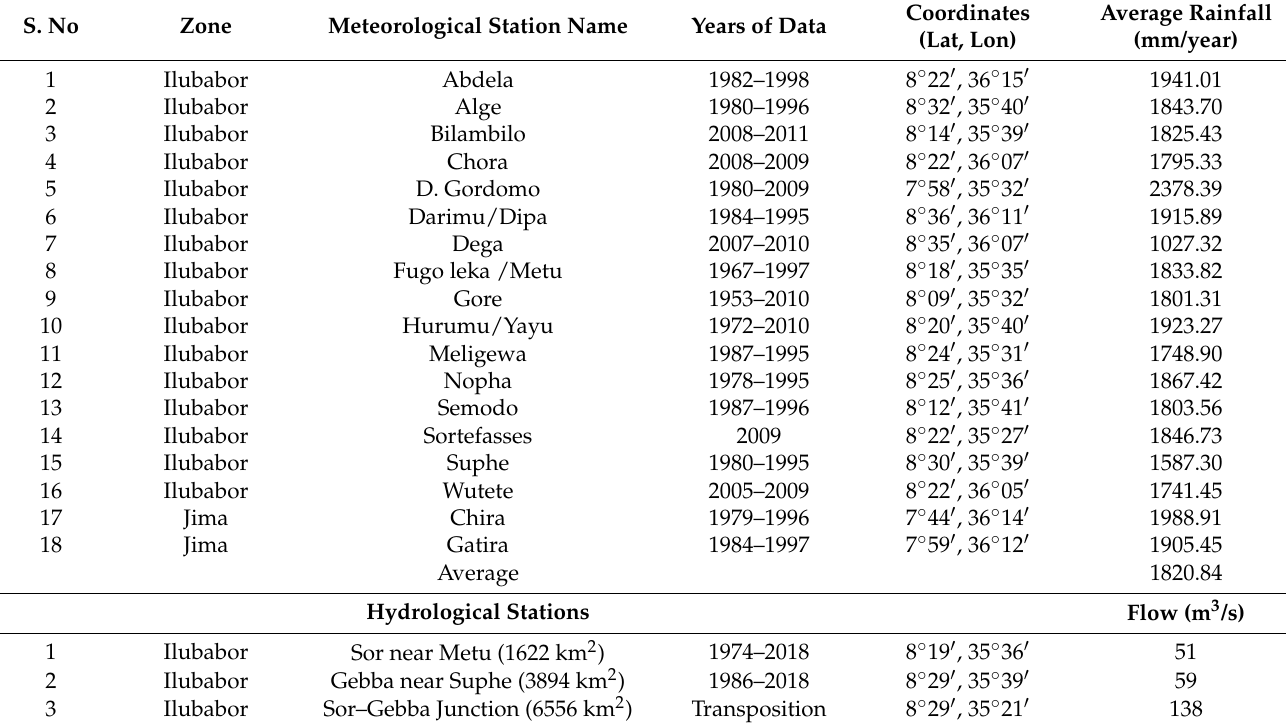
Figure 6. Location and distribution of meteorological and hydrological stations. Table 1. Meteorological and hydrological stations considered for this study.